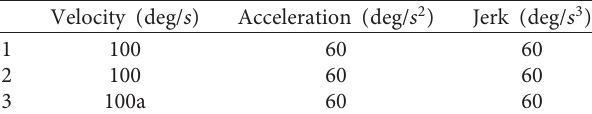
Table 1: Mechanical constraint of each